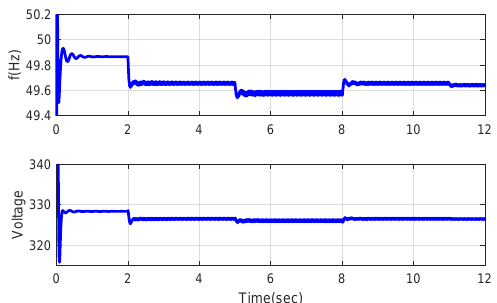
Figure 14. Instantaneous voltages at the DG terminals during unbalanced load changes in feeder F 1 , ( a ) DG 1 and ( b ) DG 2 .